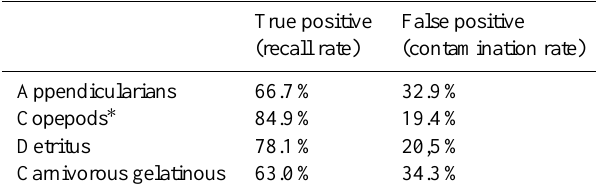
Table 1. Performance of the automatic recognition for the zoo- plankton groups analyzed using the